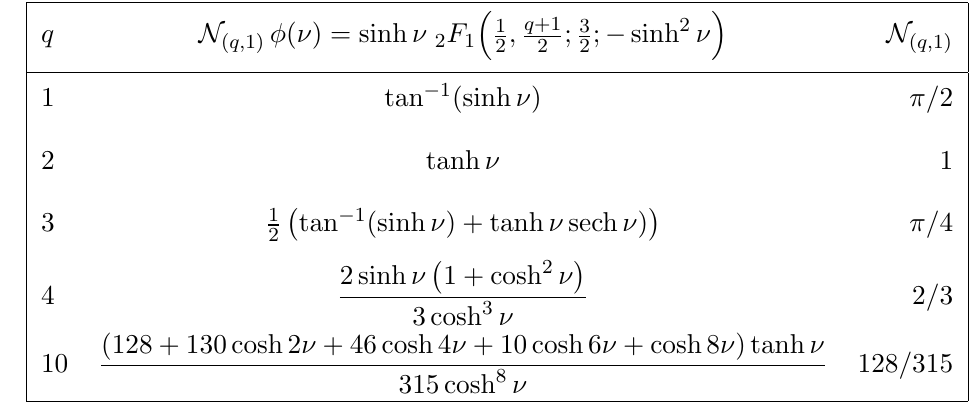
Figure 5 . Allowed values of ( q; l ) in the double BPS limit that lead to a (cid:12)nite E are represented by the solid circles. The notational conventions used in (cid:12)gure 4 are still valid in this (cid:12)gure. The main di(cid:11)erence between the two (cid:12)gures is that there is no double BPS solution if ( q; l ) = (1 ; 2) as denoted by the open red diamond above. The concentric circles indicate values of ( q; l ) where we have found exact solutions to the double BPS equations of motion in terms of well known special functions: trigonometric, hyperbolic, Bessel, and hypergeometric. The dashed circle is an exact solution for the case (4 ; 2) in terms of the not well known con(cid:13)uent Heun functions; this explicit solution is not very illuminating.